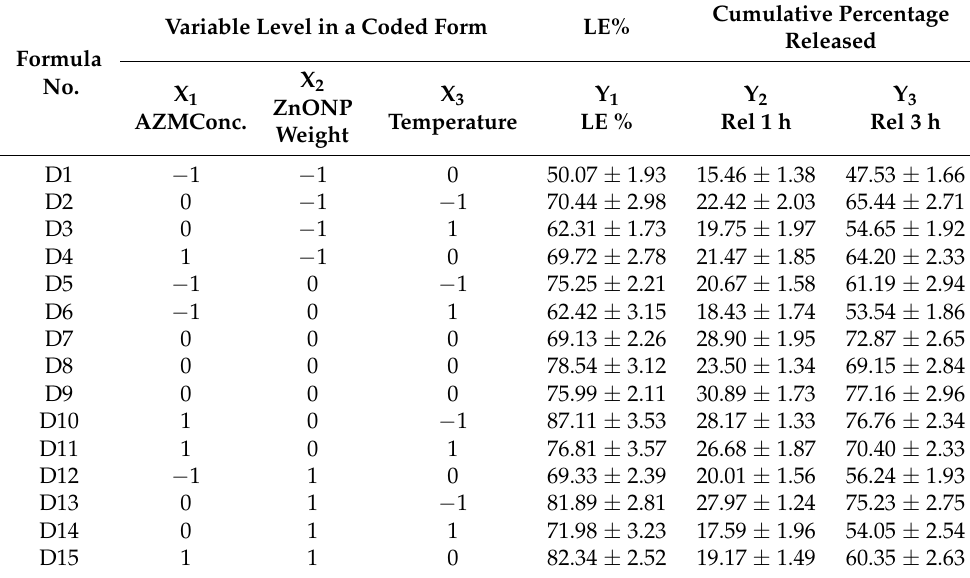
Table 4. Observed values of responses for AZM–zinc oxide nanoparticles (AZM-ZnONPs). Variable Level in a Coded Form Formula No.